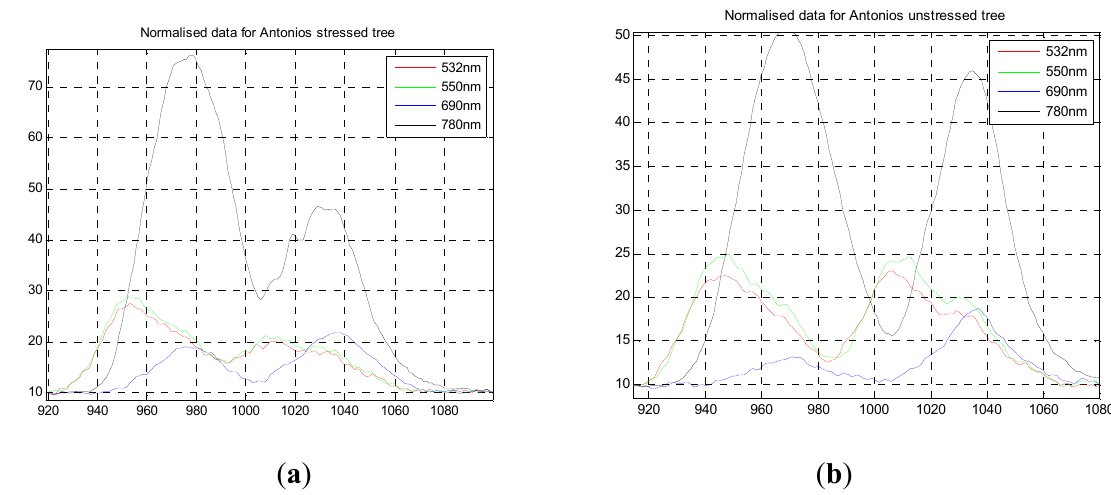
Figure 3. Comparing ( a ) NDVI and ( b ) PRI as a function of time (depth) on Cupressus macrocarpa